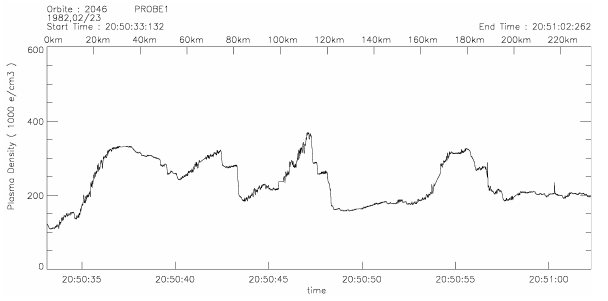
Fig. 2. Electron density profile extracted from ISOPROBE data, along the satellite path, for a 23 February 1982 orbit.